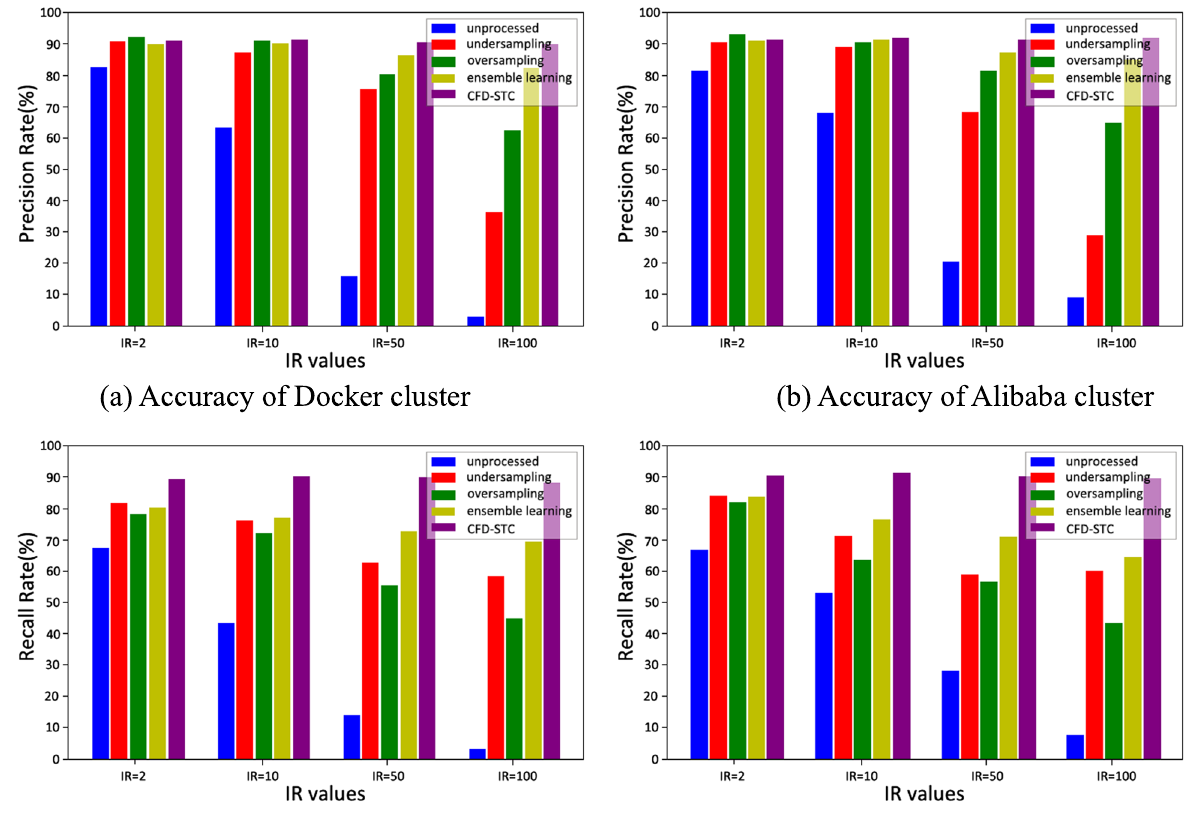
Fig. 12 Detection effect of cascade faults under different IR